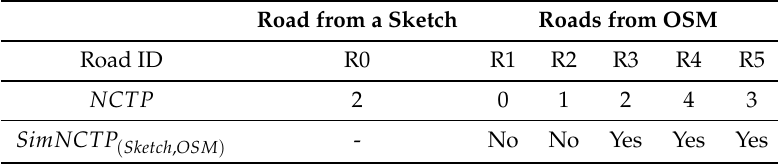
Table 2. NCTP of R0 and R1–R5. (The threshold of the direction difference is 36 ◦ ).